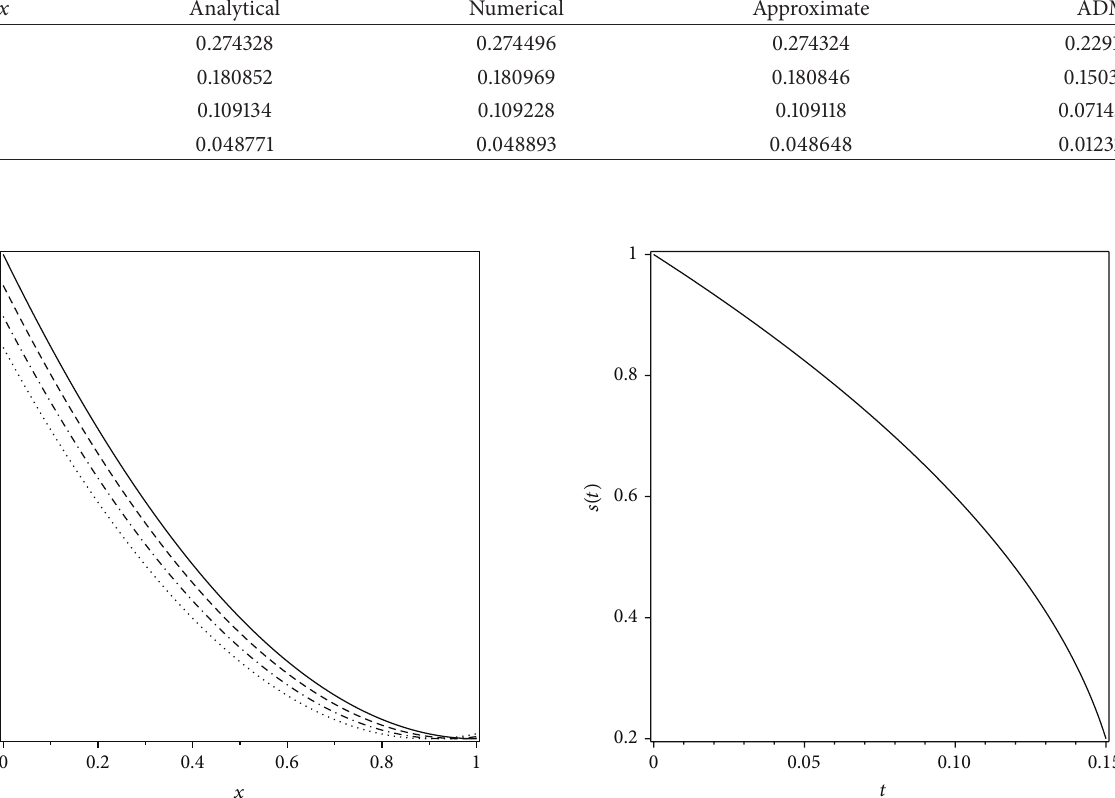
Figure 2: Variation of the moving boundary position equation (33) with the time 𝑡 for 0 ≤ 𝑡 < 0.156